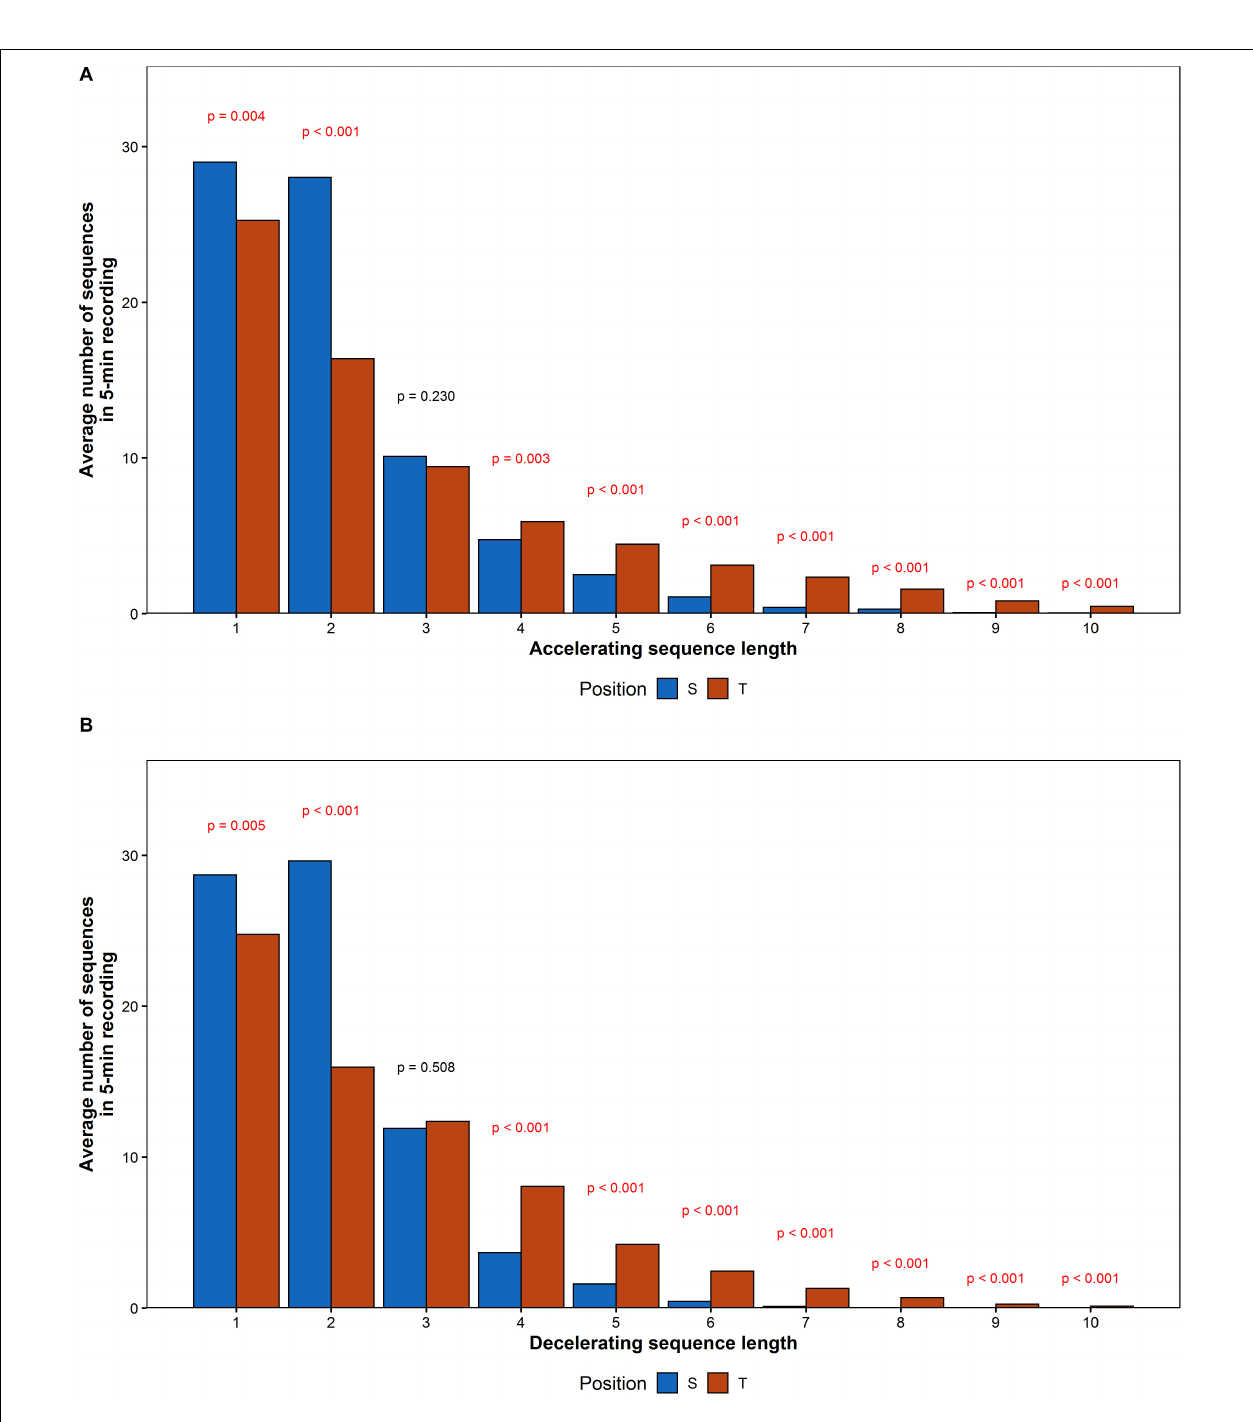
FIGURE 8 | The comparison of mean number of (A) accelerating and (B) decelerating monotonic RR series recorded during the